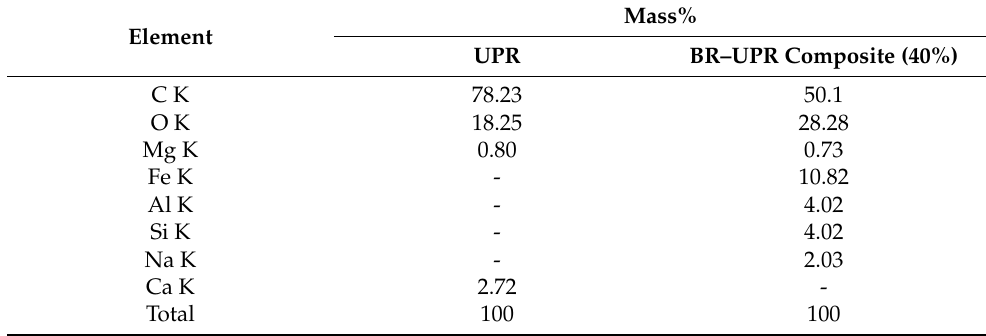
Figure 12. ( a ) EDX of UPR; ( b ) 40 vol.% UPR–BR composite. Table 4. EDX characteristics of polyester and BR–UPR